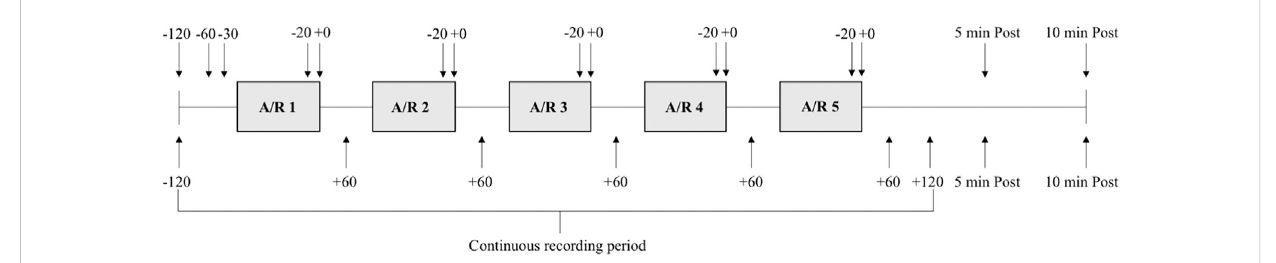
FIGURE 1 Schematicoverviewoftheexperimentalprotocol.Eachgreyboxindicatesaperiodofapneaorrebreathing(A/R).Eachsubjectperformedoneseries of fi ve apneas and one series of fi ve rebreathing episodes. Solid lines between boxes indicates 2 minutes of rest between each maneuver. Arrows with time stamps (seconds) indicate when ultrasound measurements (above boxes) and venous blood samples (below boxes) were collected in relation to each apnea or rebreathing, as well as fi ve (5 min Post) and 10 min (10 min Post) after termination of the fi fth apnea or rebreathing in the